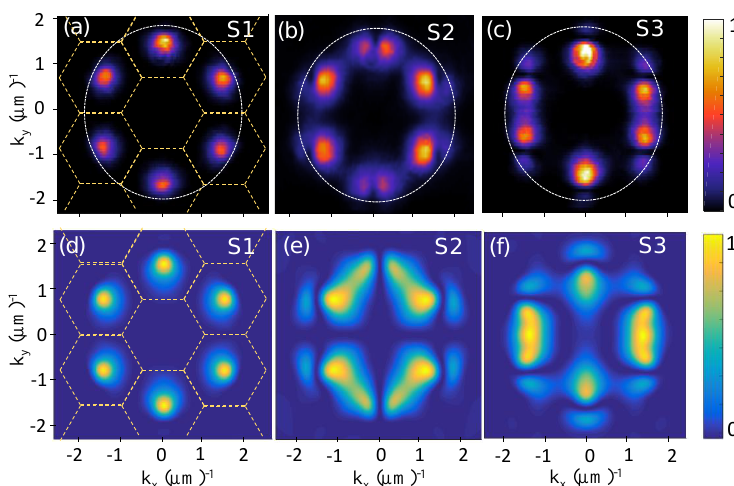
Figure 6: (a)-(c) Measured momentum space patterns of the S1, S2 and S3 gap states. Hexagons in (a) represent the reciprocal Bravais lattice. Dotted circles indicate the numerical aperture of the imaging setup. The intensity in each panel has been in- dependently normalised. (d)-(f) Momentum space of the gap states obtained from direct Fourier transform of the calculated eigenfunctions shown in Fig.